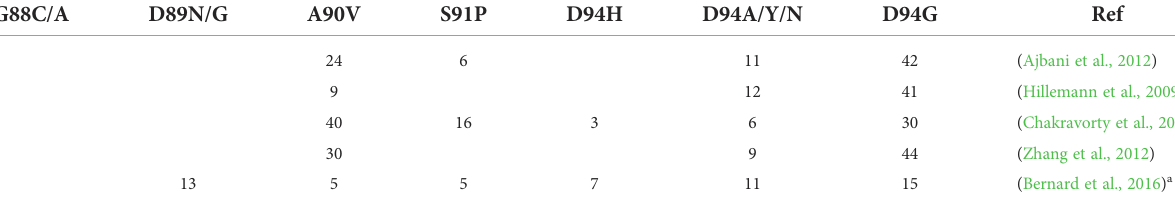
TABLE 1 Examples of GyrA alleles associated with resistance in